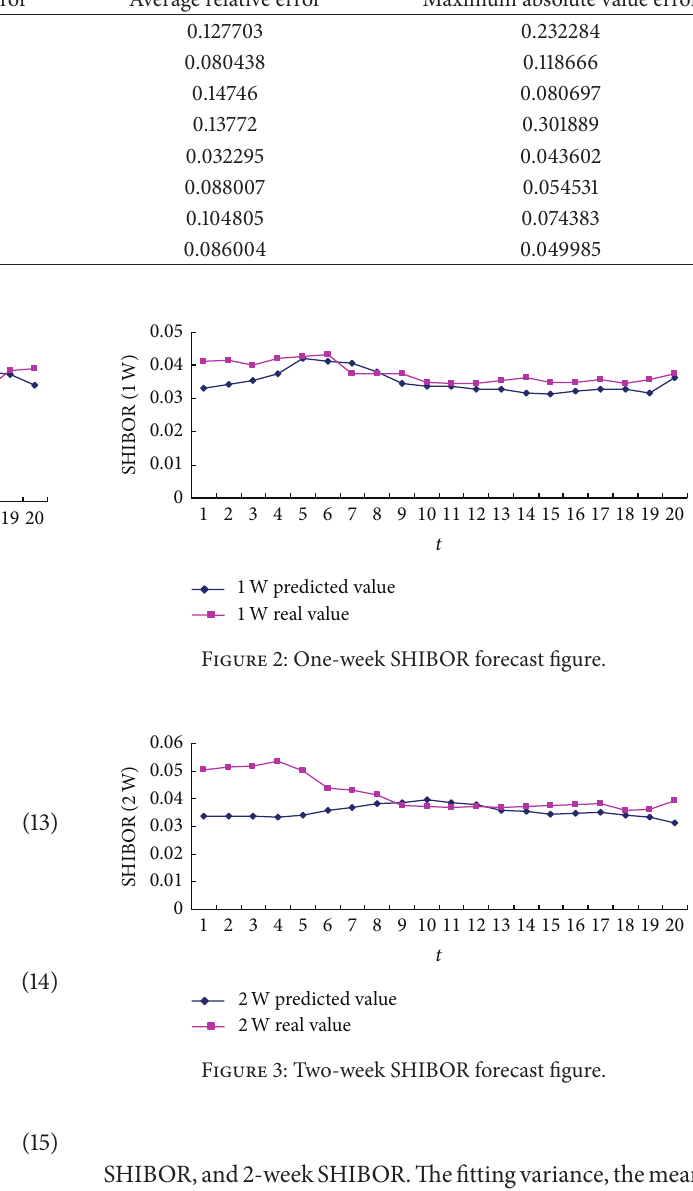
SHIBOR, and 2-week SHIBOR. The fitting variance, the mean square error, and the average relative error of 1-year SHIBOR are less than these of SHIBOR of the former four